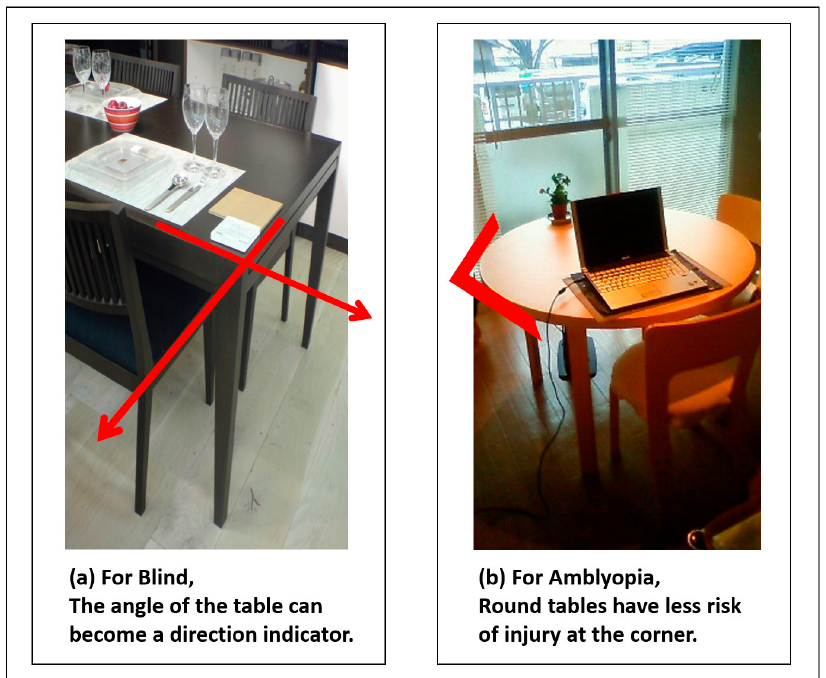
Figure 10. Shape-sensing information: ( a ) positional information for the blind persons; ( b ) round tables are less suited for the blind but good for patients with amblyopia.